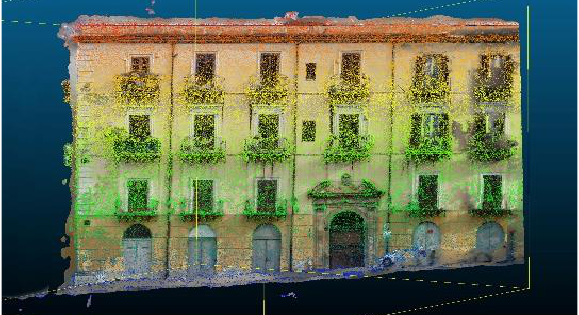
Figure 9: Merge cloud of Super-Image data set dense cloud and ground truth dense cloud. The red colour indicates a major RMS value than blue